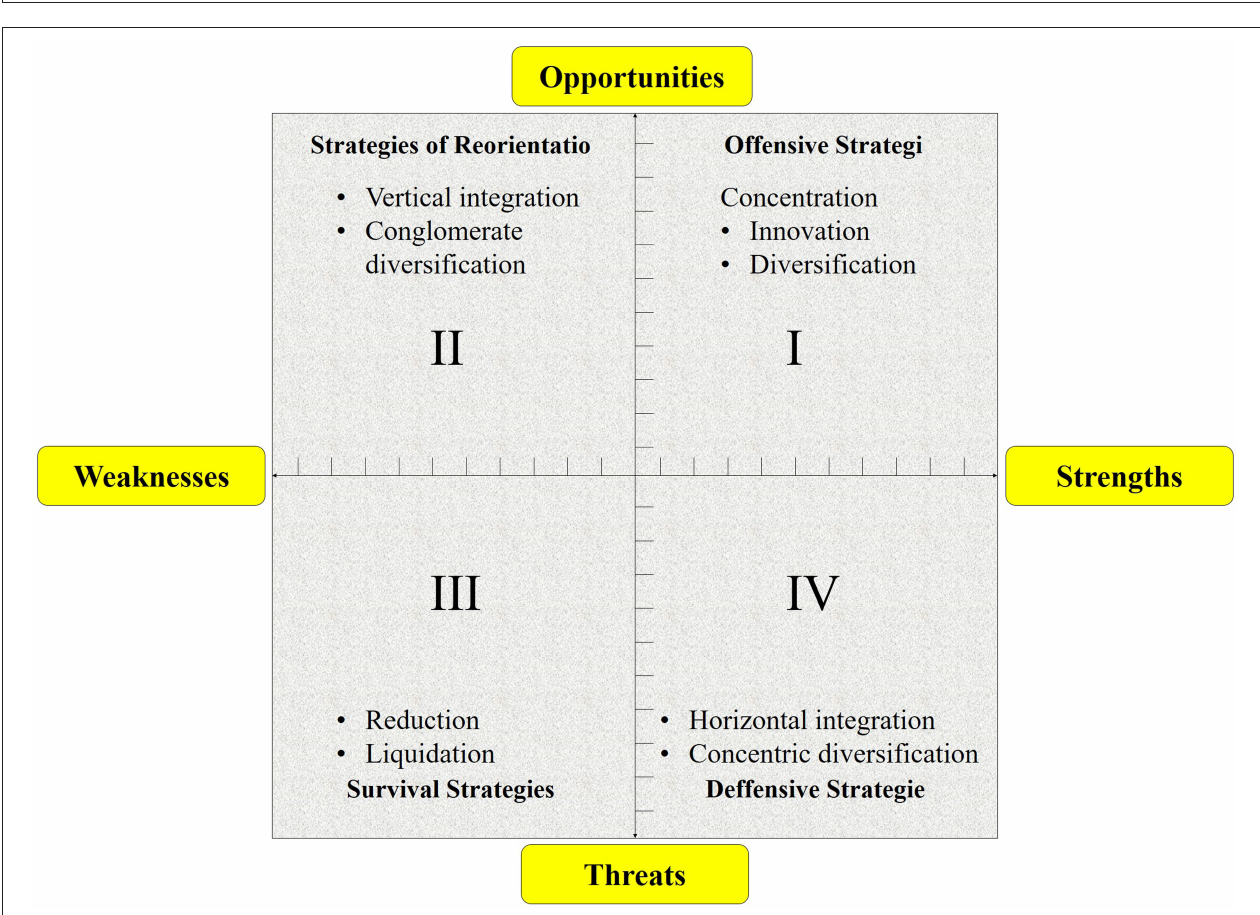
FIGURE 2 | Coordinate the model of strategic options [modification from Petkov et al. (2018)].